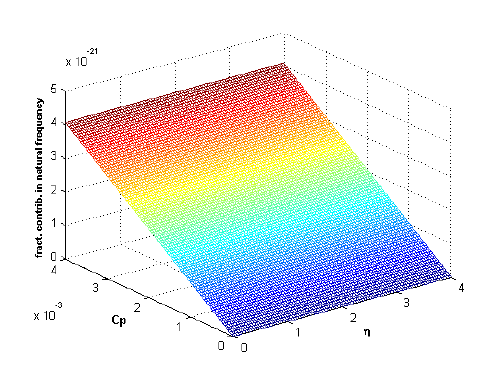
Figure 17. Fractional contribution frequency versus fractional damping coefficient Cp and nonlocality η ( α =